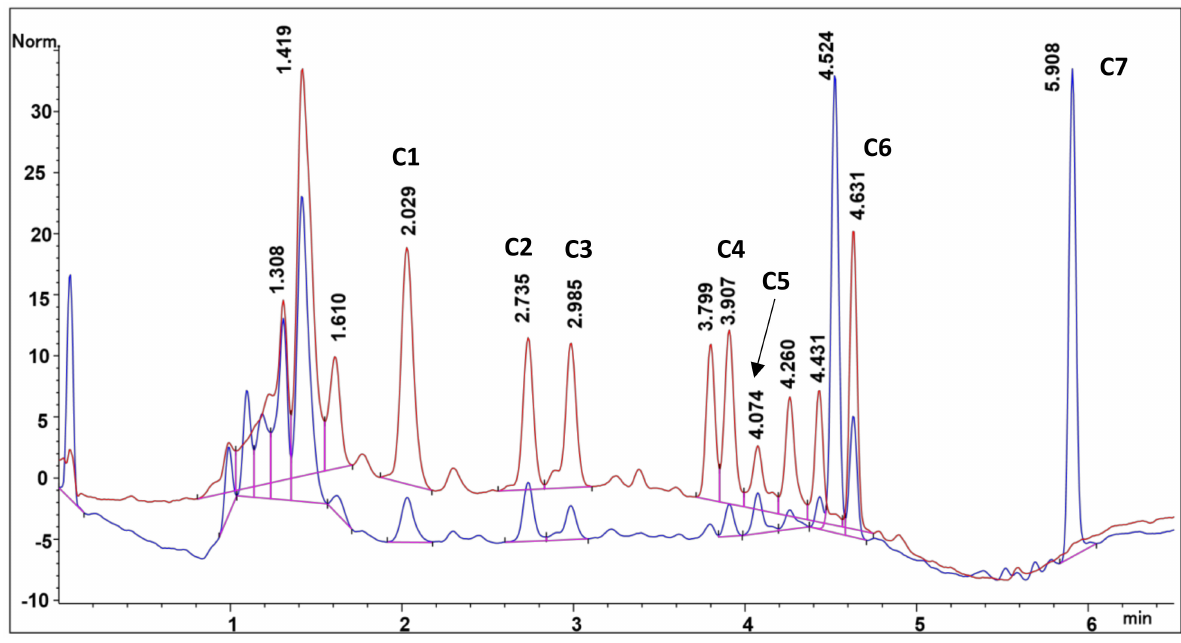
Figure 5. Chromatogram representing the separation of the Mondia whitei roots powder spiked with the compounds of interest under optimised conditions by gradient elution mode; at 0 min 25% B, 2 min 40% B, 3 min 65% B, 4 min 100% B with a run time of 6.5 min. Injection volume of 5 µ L, flow rate of 1.3 mL min − 1 and temperature of 25 ◦